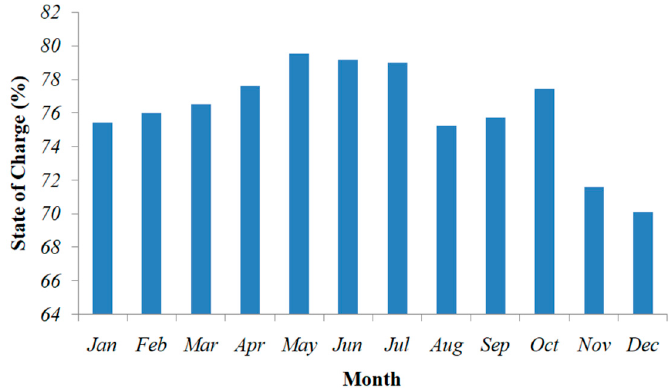
Figure 17. Yearly profile of the SOC of batteries for PV–BSS configuration.